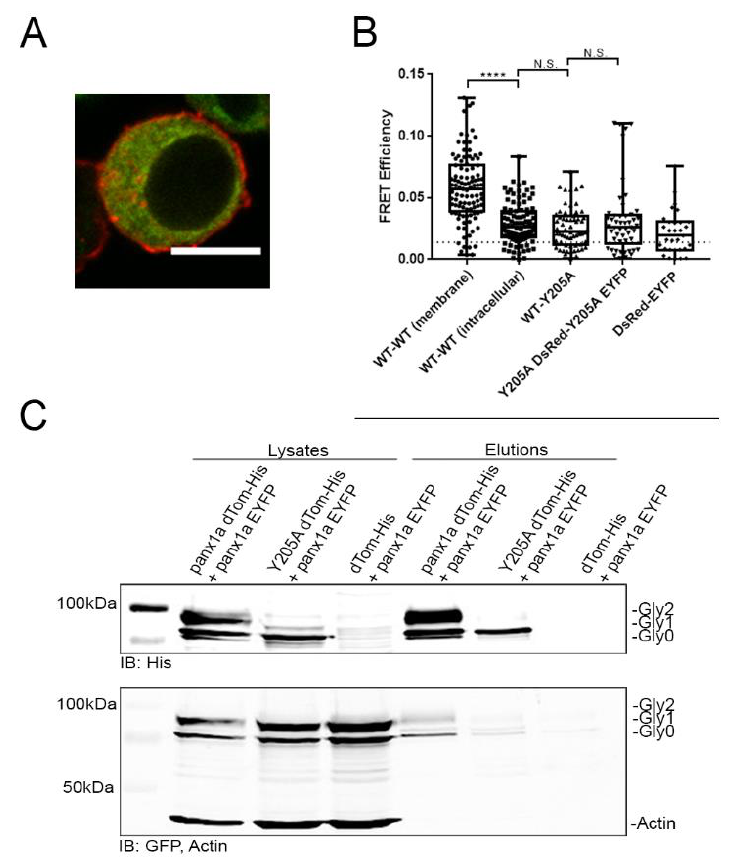
Figure 5. Interaction studies of panx1a and the Y205A mutant using FRET and pull-down assay. ( A ) Fluorescent image showing a Neuro 2a cell transfected with panx1a-DsRed and Y205A-EYFP. Scale bar: 10 µ m. ( B ) FRET e ffi ciencies. WT–WT (membrane) ( n = 103) indicates panx1a-DsRed interaction with panx1a-EYFP using selected cell membrane regions as a positive control. WT–WT (intracellular) ( n = 100) indicates panx1a-DsRed interaction with panx1a-EYFP using selected regions inside the cell. WT-Y205A ( n = 63) indicates panx1a-DsRed interaction with Y205A-EYFP inside the cell. Y205A-Y205A ( n = 50) indicates Y205A-DsRed interaction with Y205A-EYFP inside the cell. DsRed-EYFP indicates DsRed interaction with EYFP inside the cell as the negative control. The dotted line represents the FRET e ffi ciency threshold of 1.4%. ( C ) His60 Ni pull-down using cells double-transfected with panx1a-dTomato-His and panx1a-EYFP, Y205A-dTomato-His and panx1a-EYFP, or dTomato-His with panx1a-EYFP. Cell lysates on the left show expression levels before pull down. Elutions on the right show proteins recovered by pull down. Anti-GFP and anti-His antibodies detected eluted proteins. An anti-ß-actin antibody served as a loading control. **** p < 0.0001, N.S., not